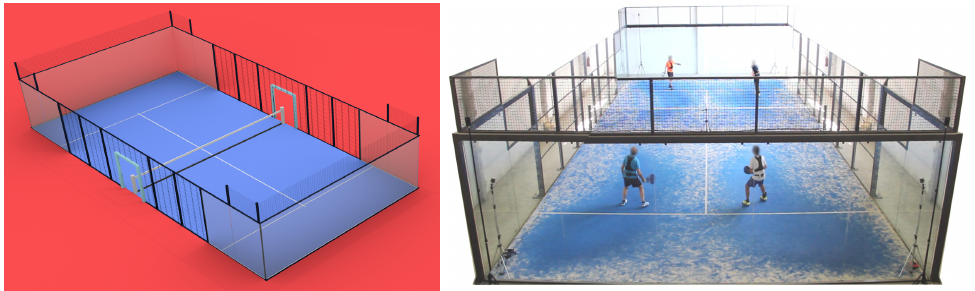
Figure 1. A padel court is substantially smaller than a tennis court. The court is enclosed by plexiglass walls and a metal